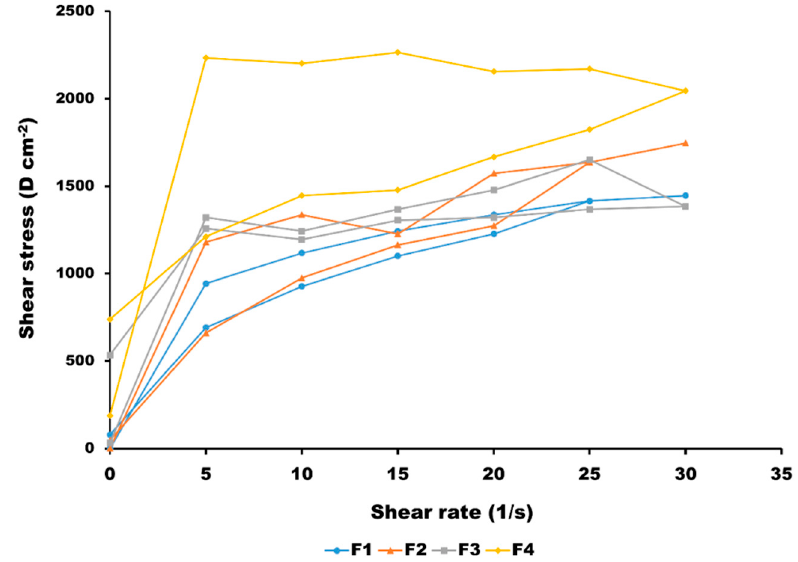
Figure 1. Rheograms of the four HQ formulations ( n = 3).